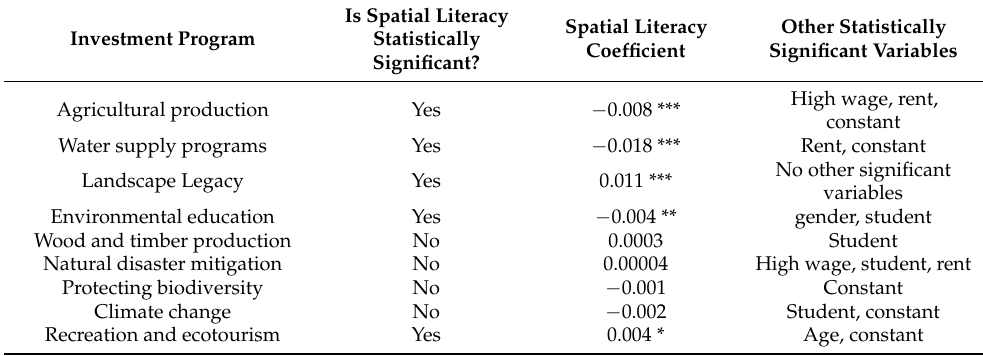
Table 5. Nonlinear probit model of the probability of a respondent selecting a given category for investing in an ecosystem service